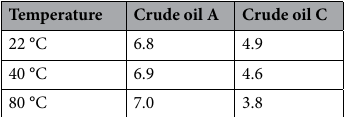
Table 2. HS-Na brine pH after mixing with crude oils A and